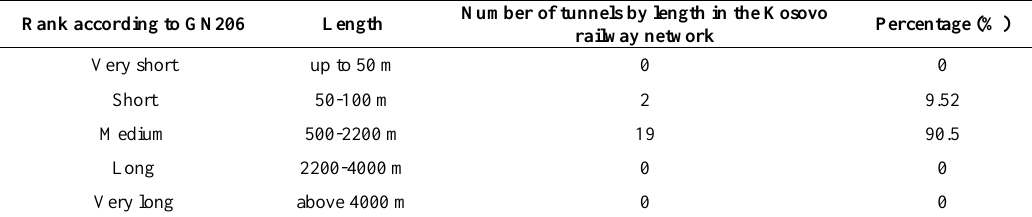
Table 6. Division of tunnels by